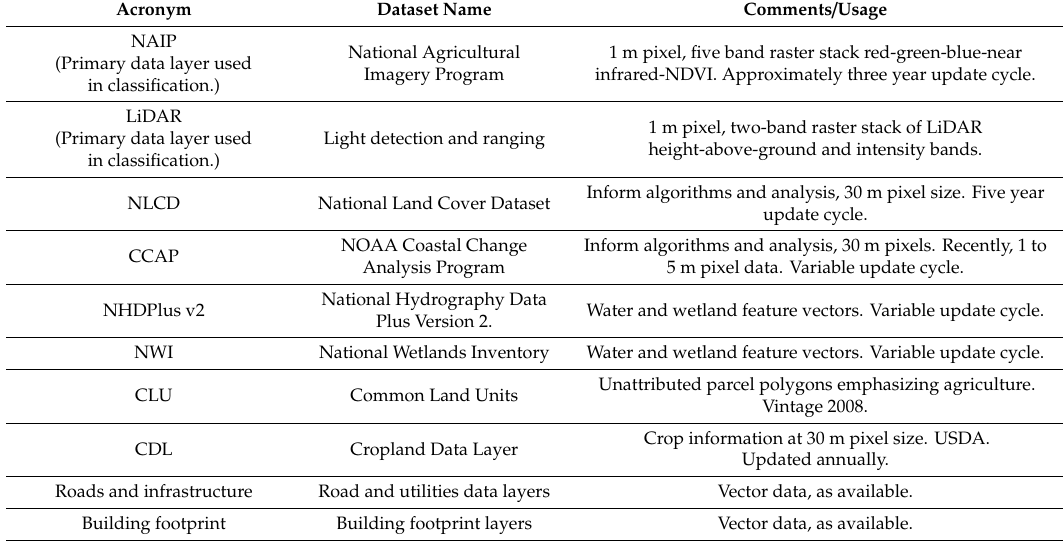
Table 1. Primary and supplemental data layers used to generate